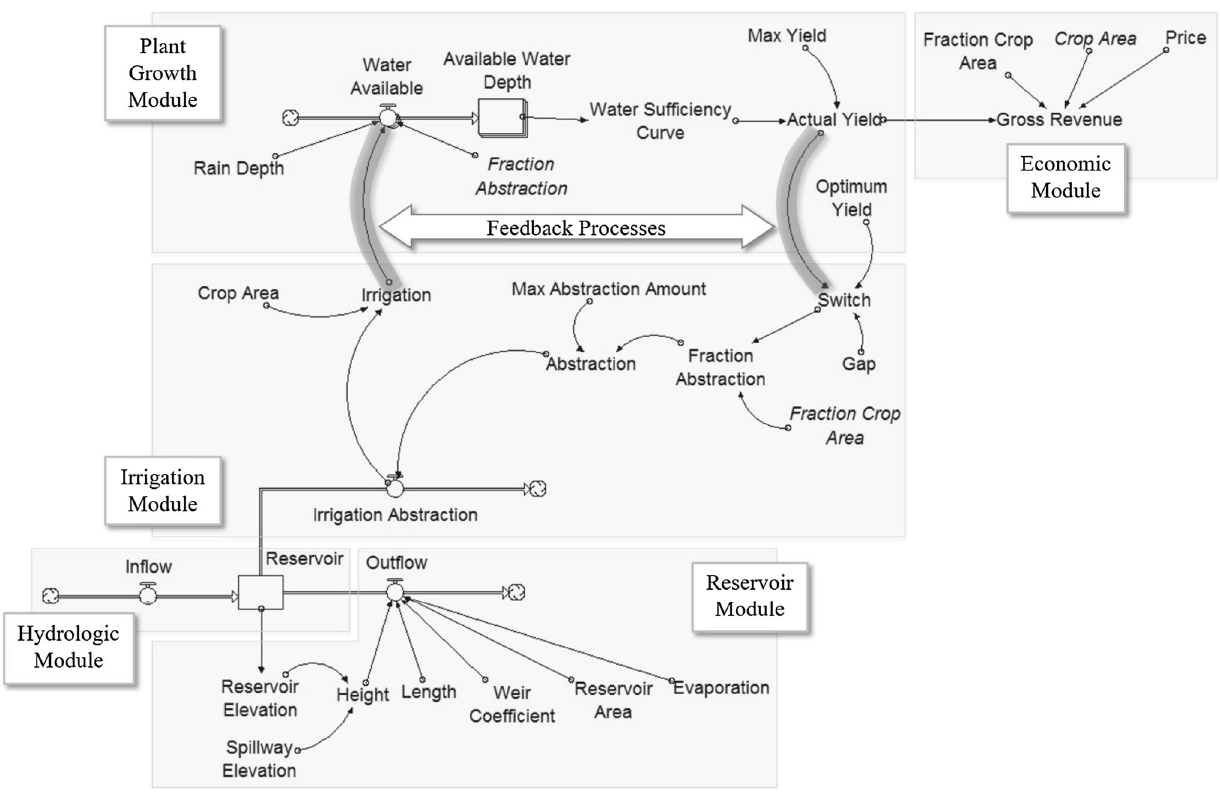
Fig. 3 Stock-flow diagram of five model system components: (1) hydrologic module with inputs from MESH, (2) reservoir module, (3) irrigation module, (4) plant growth module, and (5) economic